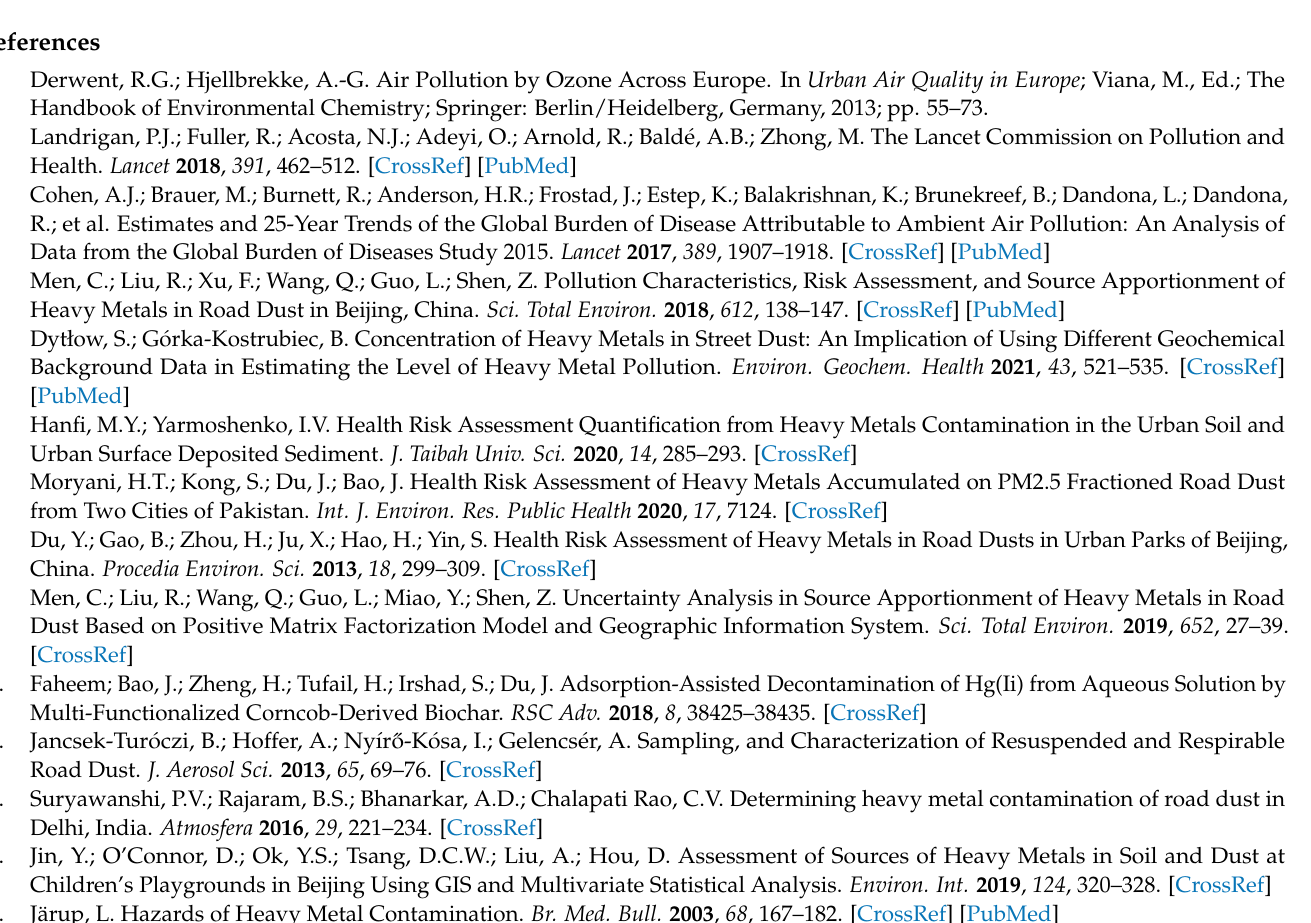
Table S3: Carcinogenic Slope Factor (CSF, (mg kg − 1 day − 1 ) − 1 ) of different PTEs used to calculate CR [19]; Table S4: Geo-accumulation index (Igeo), contamination factor (Cf), degree of contamina- tion (Cd) and pollution load index (PLI) of PHEs in ACFD of Jubail, Dammam metropolitan and Jeddah mosques; Table S5: Classification values and qualitative description of enrichment factor, geo-accumulation index, contamination factor, and ecological risk indices. Refs [136–158] are cited in Supplementary